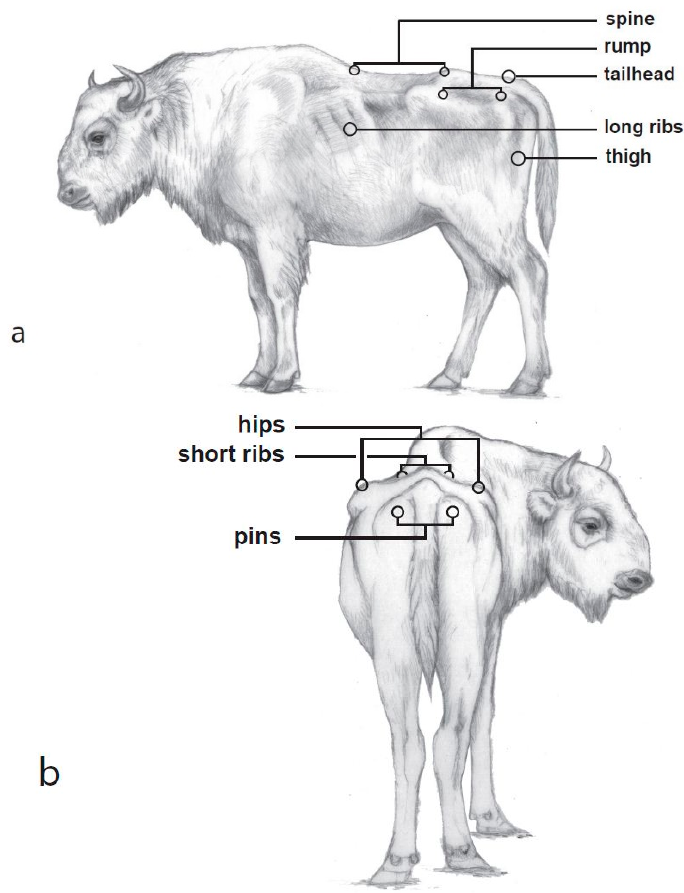
Figure 1. Key areas for assessing body condition score in European bison ( Bison bonasus ). ( a ) Left side view; ( b ) back view. Area names are consistent with the corresponding body condition score (BCS) labels.